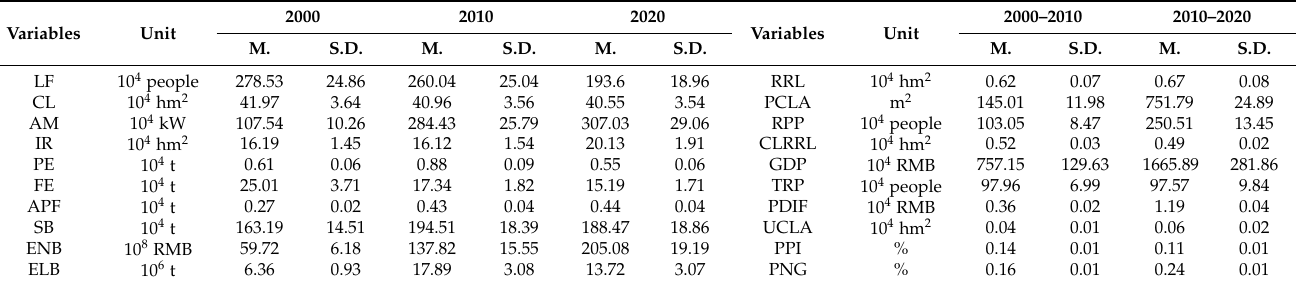
Table 3. Basic characteristics of research